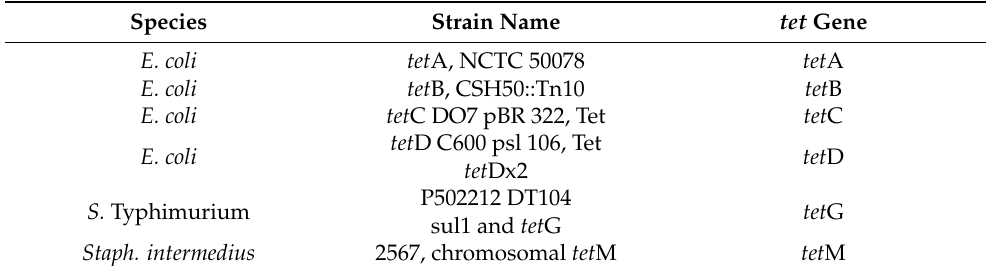
Table 4. Positive control strains used for tet gene PCR-based characterisation provided by the European Reference Laboratory for Antimicrobial Resistance (EURL-AR, Technical University of Denmark, National Food Institute). Species Strain Name tet Gene E. coli tet A, NCTC 50078 tet